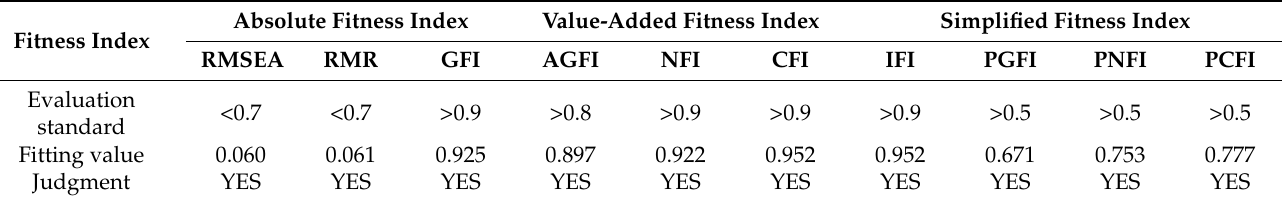
Table 5. Results of model fitness test ( n =